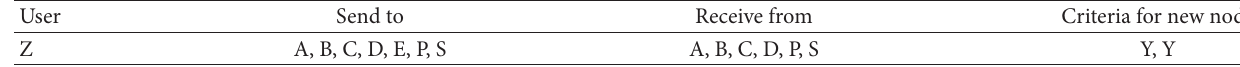
Table 4: Send to/receive from preferences of a new node